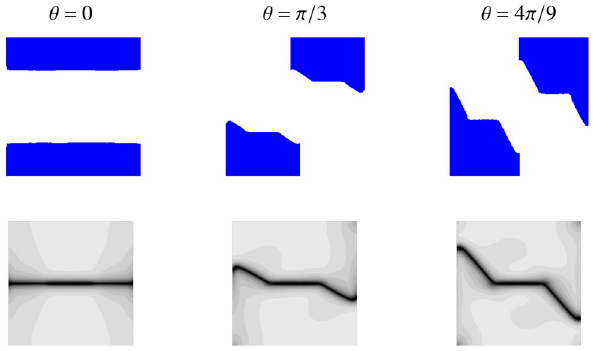
Fig. 5 Final crack shapes with kinks under the given boundary dis- placement g = ± 10 t ( sin θ ,cos θ) on Γ ± mation (upper) and contour lines of z (lower) at t = 0.1 )